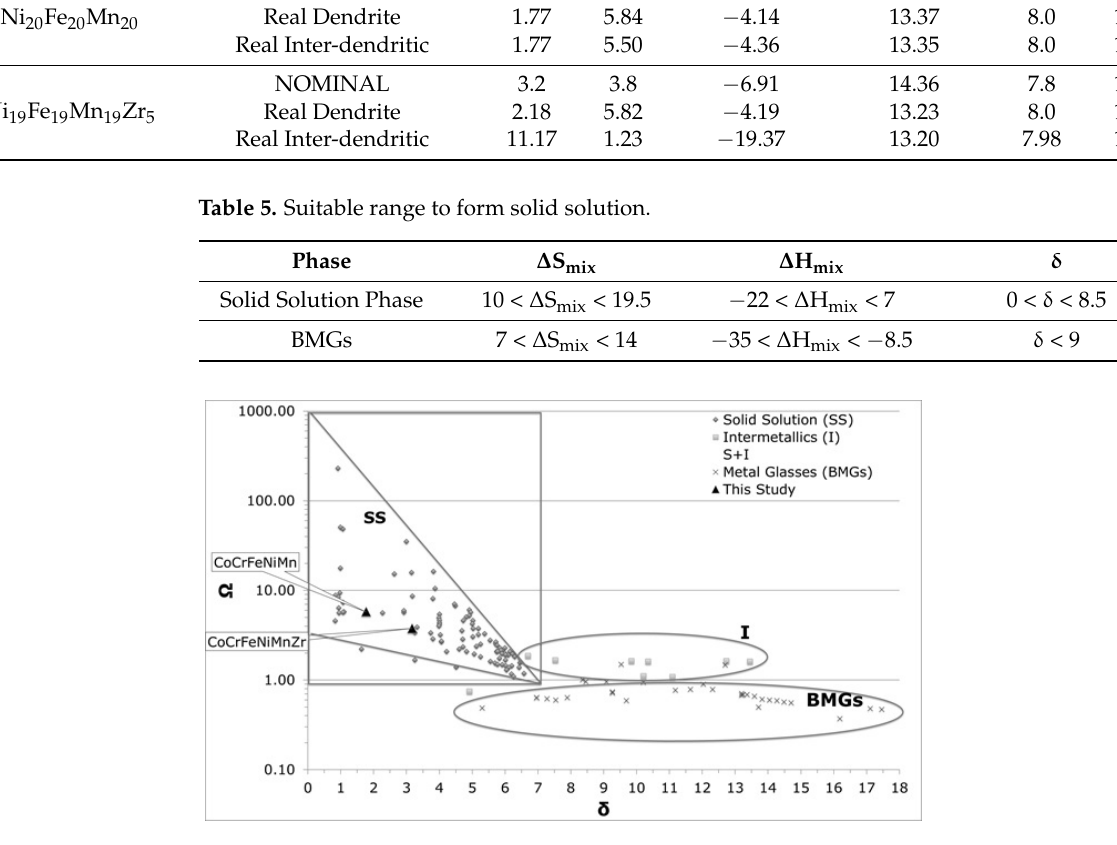
Figure 5. Phase formation according to Ω and δ parameters.